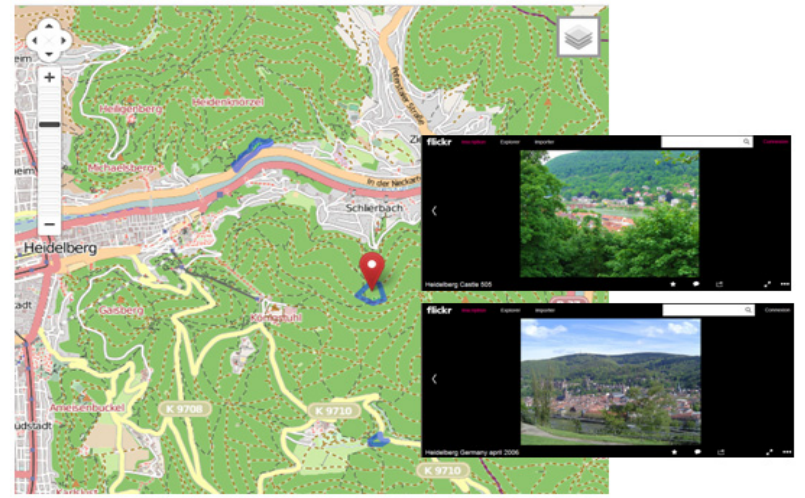
Figure 12. Combining OSM with Flickr pictures with the support of the Unified